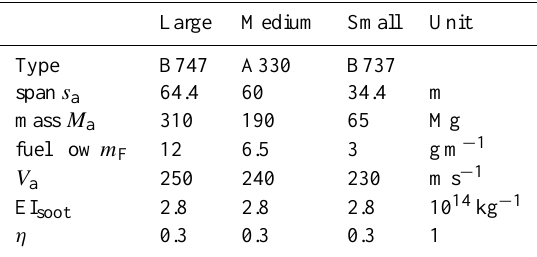
Fig. 12. Distribution of total cirrus-cover composed of natural cirrus and contrail-cirrus for a North American region, with a contrail out- break. Top: contrail-cirrus pixels (red); bottom: natural cirrus pixels (blue) and contrail-cirrus pixels (red).